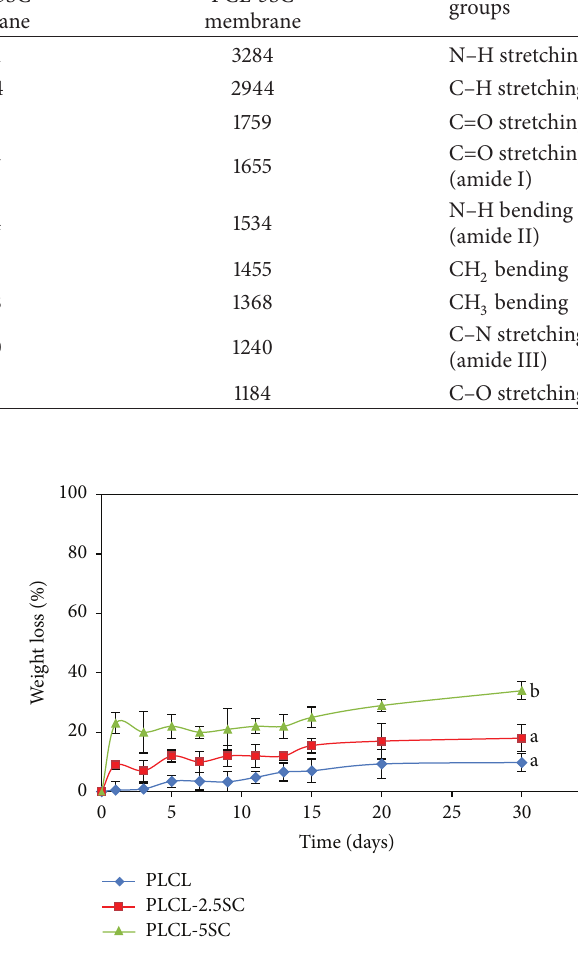
Figure 5: Percent of weight loss of membranes, submerged in PBS, over 30 days at 37 ± 1.0 ∘ C. Statistical differences between each group are represented as the lowercase letters (a, b) ( 𝑝 ≤ 0.05